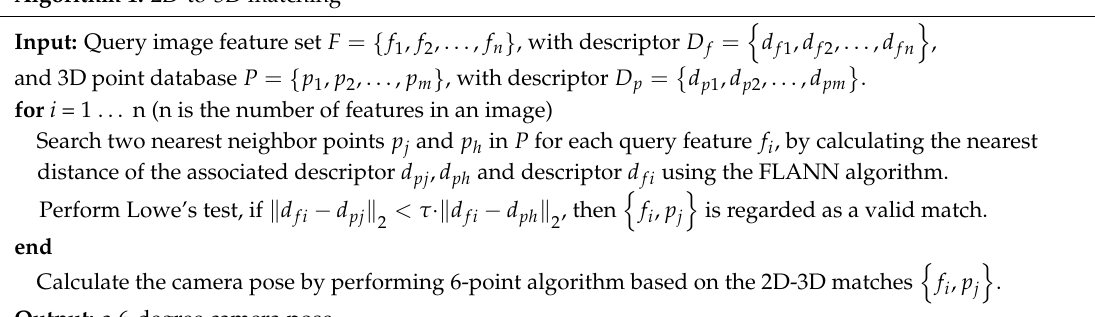
Algorithm 1. 2D-to-3D